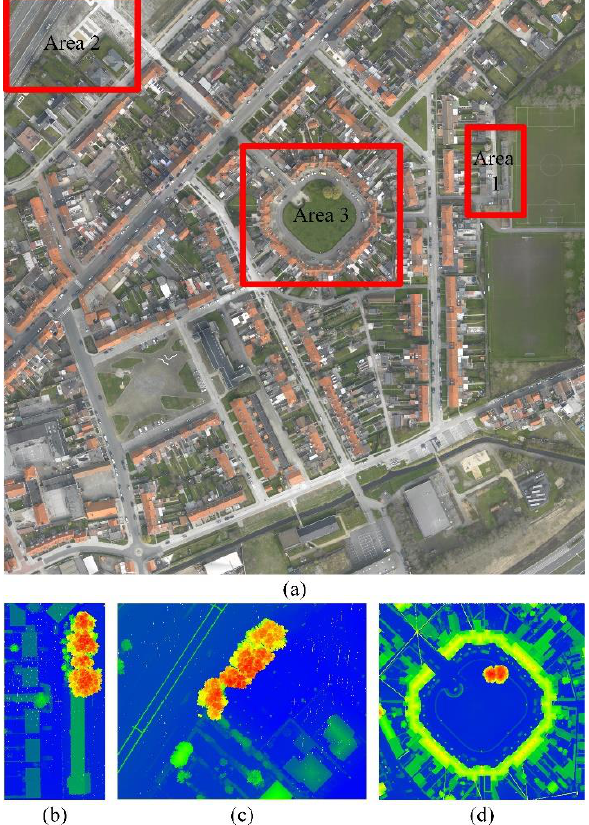
Figure 5 . a) IEEE dataset of the Zeebruges, Belgium area, b) area 1, c) area 2, d) area